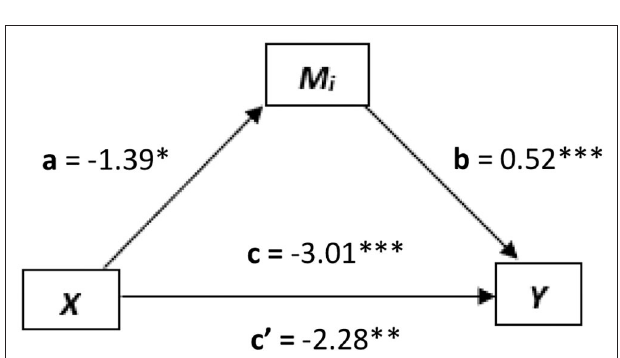
TABLE 5 | Model summary where alexithymia DDF is DV.